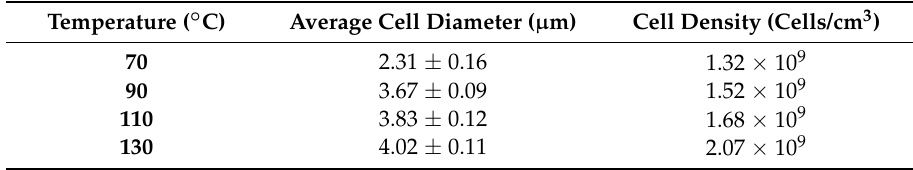
Table 1. Average cell diameter and cell density of SAN/CPE foams with 20 wt.% CPE at different temperature with same soaking pressure of 15 MPa.